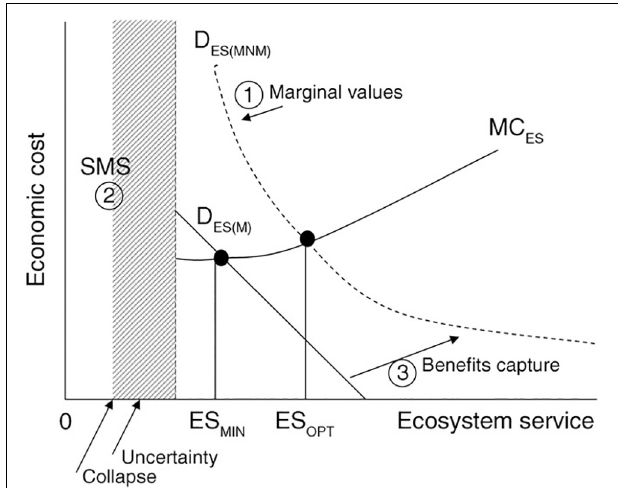
FIGURE 3 | The graphic representation of the economic demand function (EDF). The D ES ( M ) curve represents the variation of ES traditionally traded in markets, thus, with use value, whereas the D ES ( MNM ) curve represents all those services which hold a non-use value. At some level of degradation, both curves behave differently, but both run into a problem of uncertainty and possible collapse. Reproduced from Fisher et al.